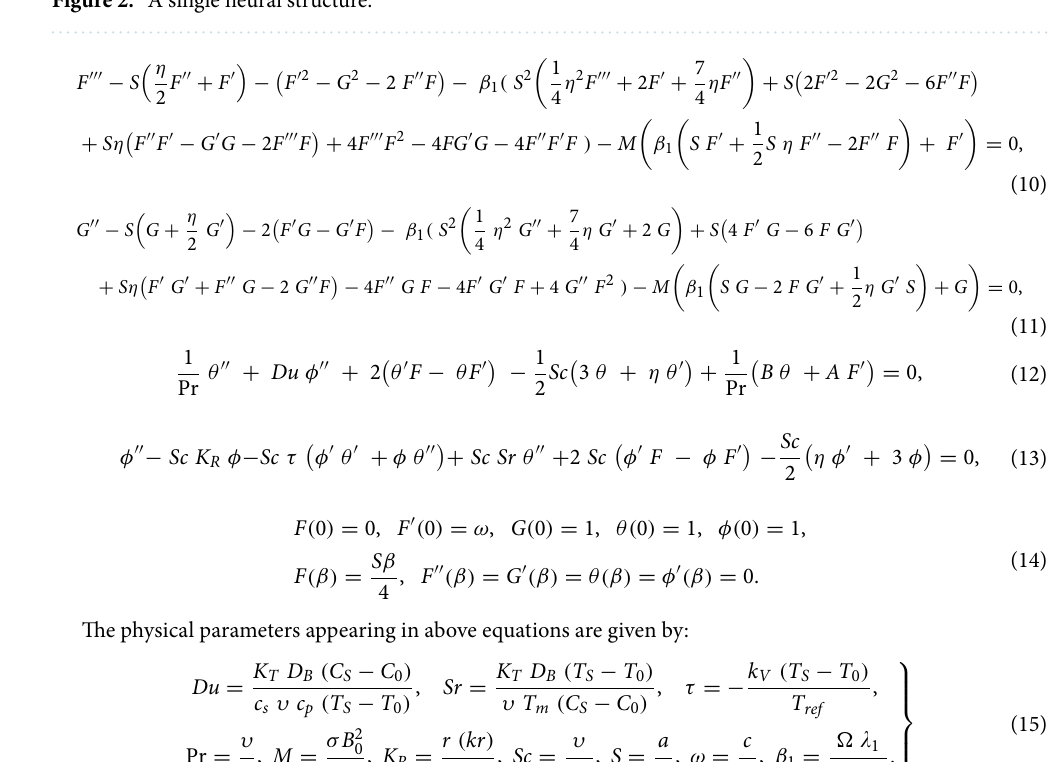
Figure 2. A single neural